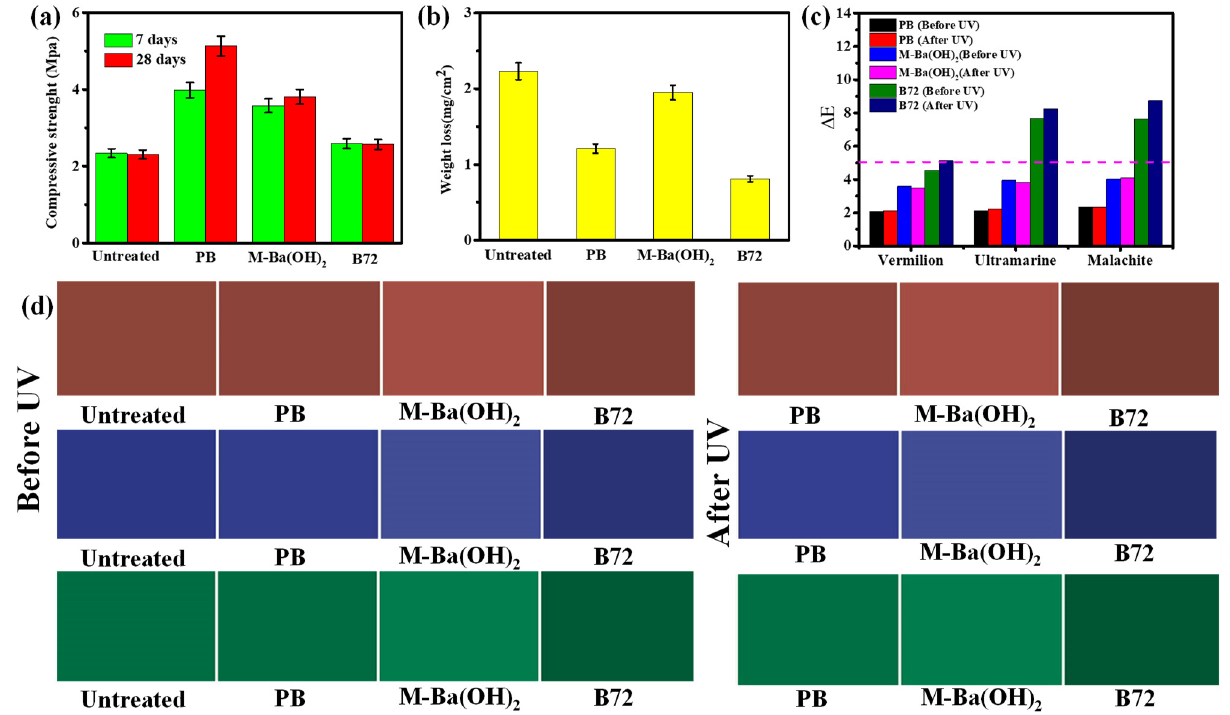
Figure 6. ( a ) Compressive strength test of simulated samples treated with PB, M-Ba(OH) 2 , and B72 at 7 and 28 days; ( b ) the weight loss of simulated samples treated with PB, M-Ba(OH) 2 , and B72 after curing in STT; ( c ) CIELAB ∆ E changes in ultramarine, cinnabar, and malachite pigments treated with PB, M-Ba(OH) 2 , and B72 before and after UV aging; and ( d ) color change pictures of simulated samples treated with PB, M-Ba(OH) 2 , and B72 before and after UV aging. While B72 did not perform as well as M-Ba(OH) 2 and PB during the compressive strength test, it performed quite well in the STT test, resulting in a loss of only 0.81 mg/cm 2